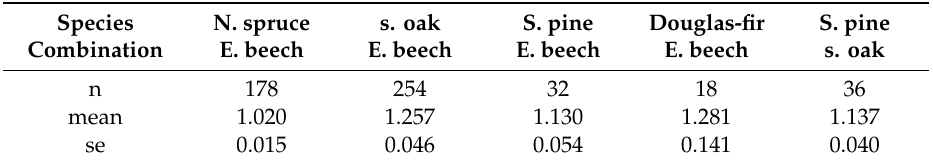
Table 2. Mean ratios and standard errors of mixed versus monospecific stand density, DMC, for species combinations represented by data and analyzed so